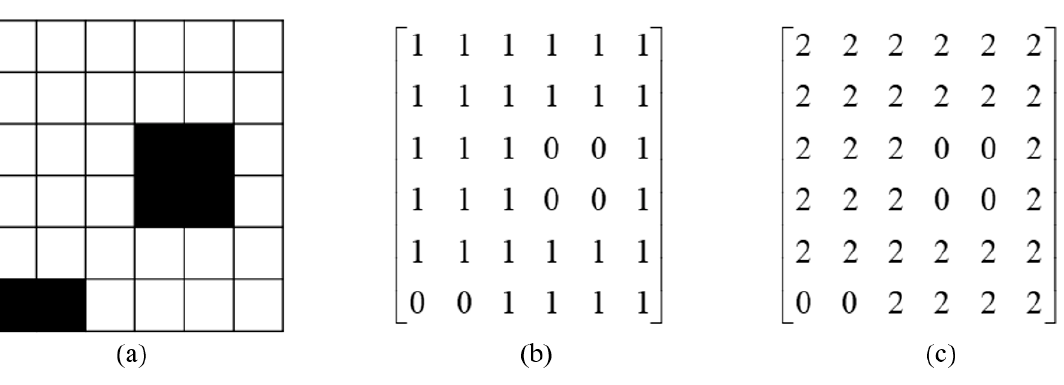
Figure 4. Grid map matrix: ( a ) grid map; ( b ) uncovered map digital matrix; ( c ) overlaid map digital matrix.